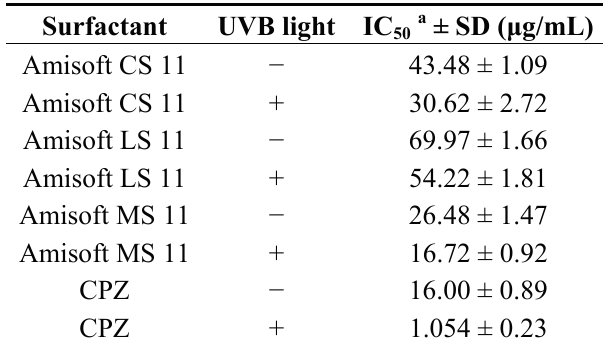
Table 2. IC values of acylglutamate surfactants and chlorpromazine (CPZ) on human 50 keratinocyte (HaCaT) cells.